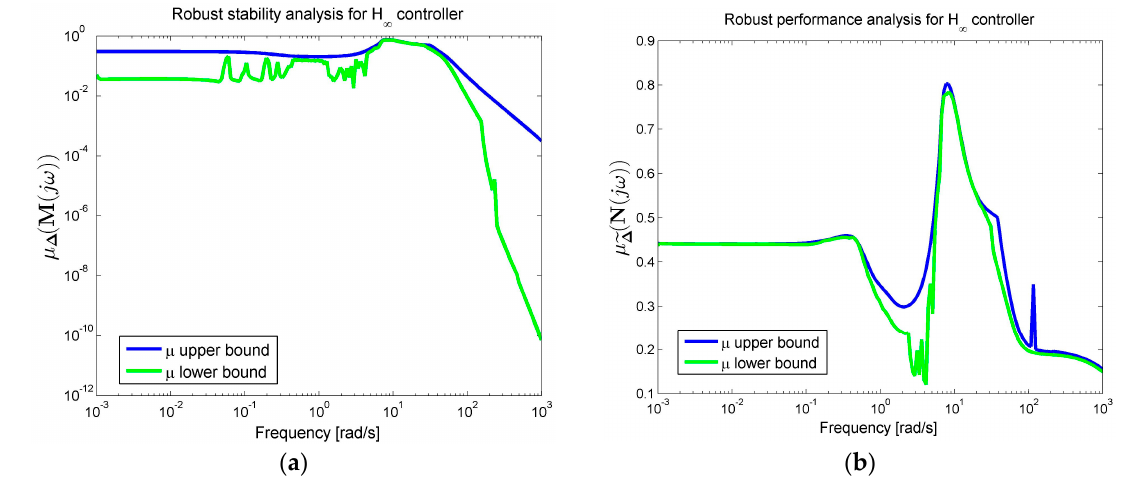
Figure 17. ( a ) Upper and lower bound of (cid:2020) ∆ ((cid:1839)) ; ( b ) Upper and lower bound of (cid:2020) ∆(cid:3560) ((cid:1840)) .